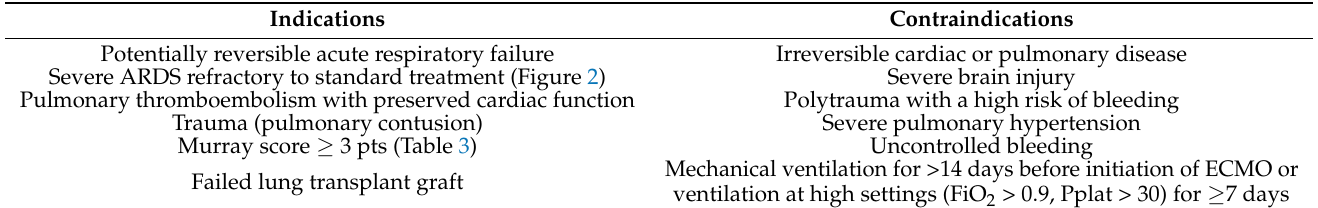
Figure 2. Conventional VV-ECMO indications for ARDS ([32], self-modified). VV-ECMO—Venovenous Extracorporeal Membrane Oxygenation, ARDS—Acute Respiratory Distress Syndrome, PaO 2 —partial pressure of arterial oxygen, FiO 2 — fraction of inspired oxygen, PaCO 2 —partial pressure of carbon dioxide. Table 2. Indications and contraindications for ECMO ([32,33],